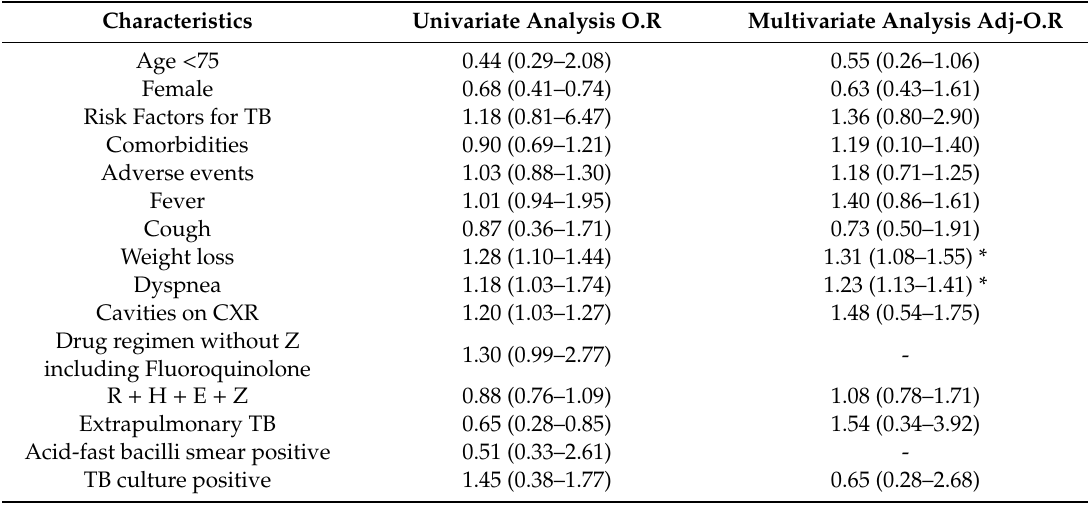
Table 4. Predictors of unsuccessful treatment outcome in elderly TB